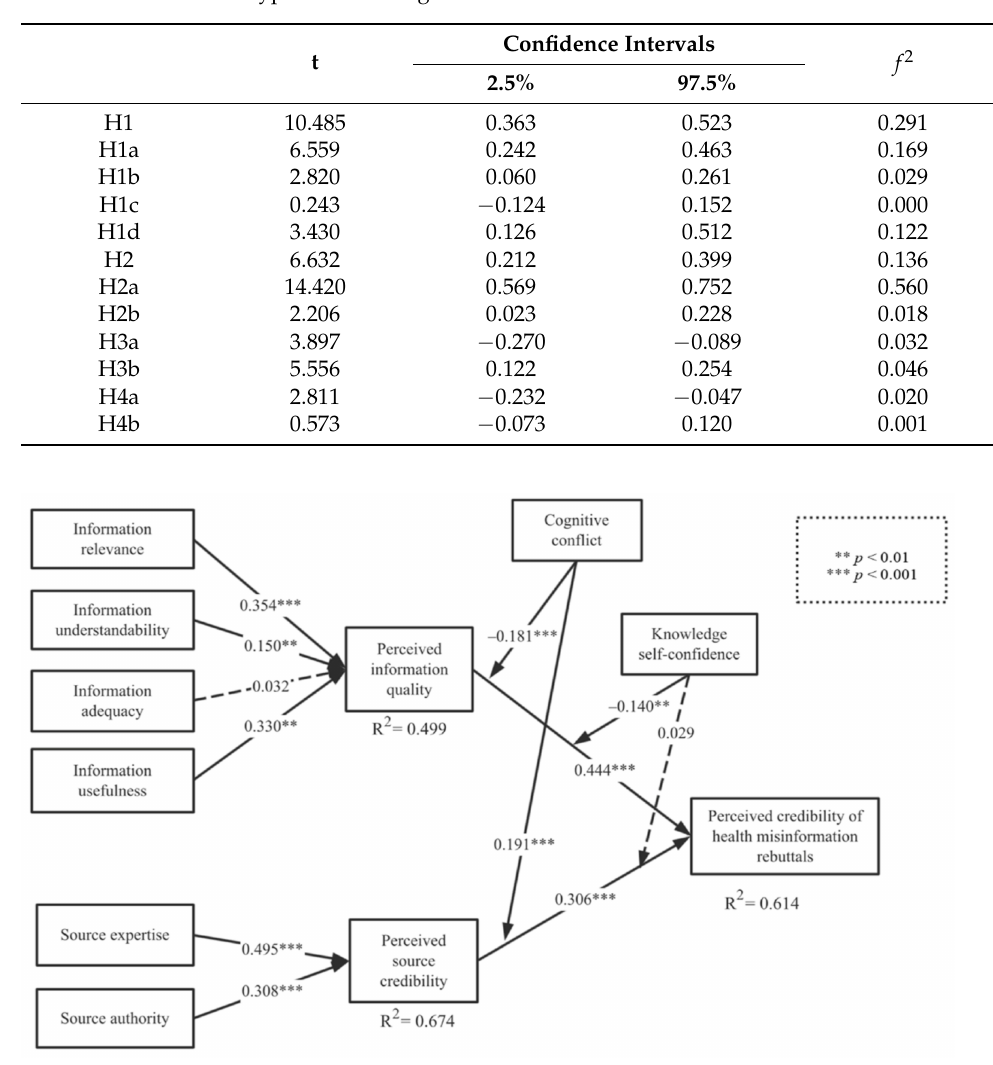
Table 7. Results of the hypotheses testing.